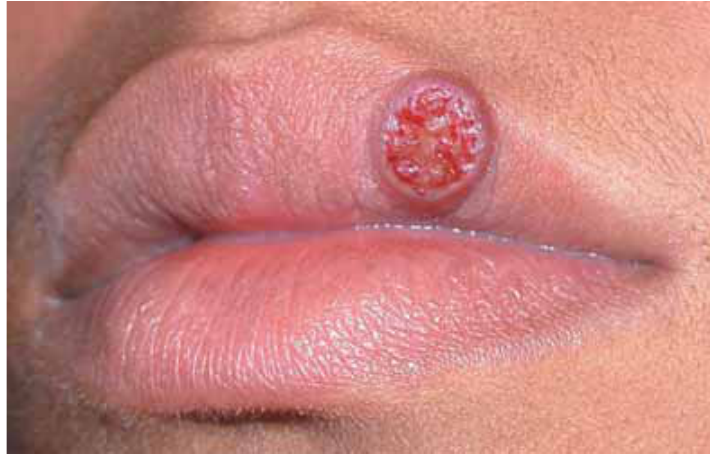
Figure 1- (cid:1)(cid:2)(cid:3)(cid:4)(cid:4)(cid:5)(cid:6)(cid:7)(cid:8)(cid:9)(cid:3)(cid:10)(cid:10)(cid:11)(cid:12)(cid:13)(cid:1)(cid:14)(cid:10)(cid:15)(cid:3)(cid:16)(cid:17)(cid:18)(cid:3)(cid:4)(cid:13)(cid:1)(cid:6)(cid:14)(cid:19)(cid:3)(cid:16)(cid:20)(cid:15)(cid:5)(cid:17)(cid:10)(cid:1)(cid:21)(cid:11)(cid:4)(cid:14)(cid:10)(cid:3)(cid:1)(cid:5)(cid:21)(cid:22)(cid:11)(cid:10)(cid:22)(cid:5)(cid:21)(cid:23)(cid:1)(cid:18)(cid:7)(cid:3)(cid:1)(cid:24)(cid:14)(cid:15)(cid:11)(cid:15)(cid:14)(cid:18)(cid:17)(cid:21)(cid:3)(cid:11)(cid:14)(cid:6)(cid:1)(cid:10)(cid:5)(cid:21)(cid:3)(cid:1)(cid:11)(cid:25)(cid:1)(cid:18)(cid:7)(cid:3)(cid:1)(cid:14)(cid:19)(cid:19)(cid:3)(cid:16)(cid:1)(cid:10)(cid:5)(cid:19)